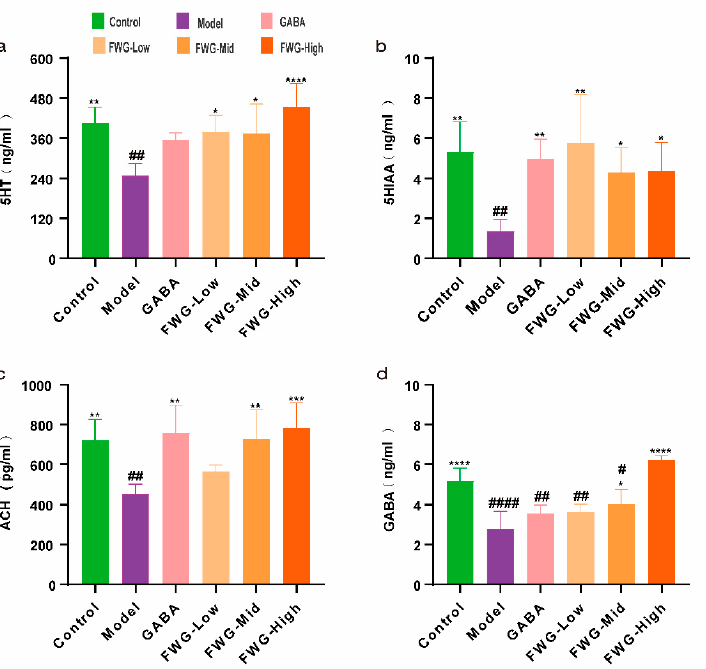
Figure 3. Effect of fermented wheat germ on neurotransmitters in the hippocampus of depressed rats. ( a ) Hippocampus 5-HT concentration. ( b ) Hippocampus 5-HIAA concentration. ( c ) Hippocampus ACH concentration. ( d ) Hippocampus GABA concentration. (* p < 0.05, ** p < 0.01, *** p < 0.001, and **** p < 0.0001 indicate an appreciable difference compared to the model group. # p < 0.05, ## p < 0.01, and #### p < 0.0001 represent that the difference was appreciable in contrast with the normal control group. N.S: statistically insignificant.)